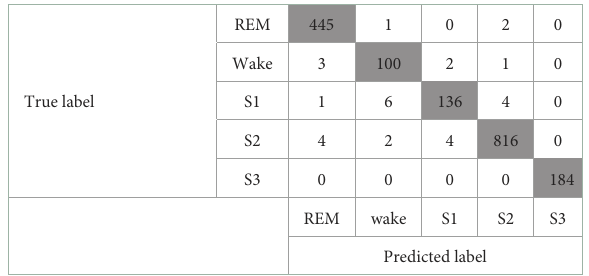
TABLE 6 Confusion matrix of the model that includes the Maxim raw features and the HRV-derived variables.